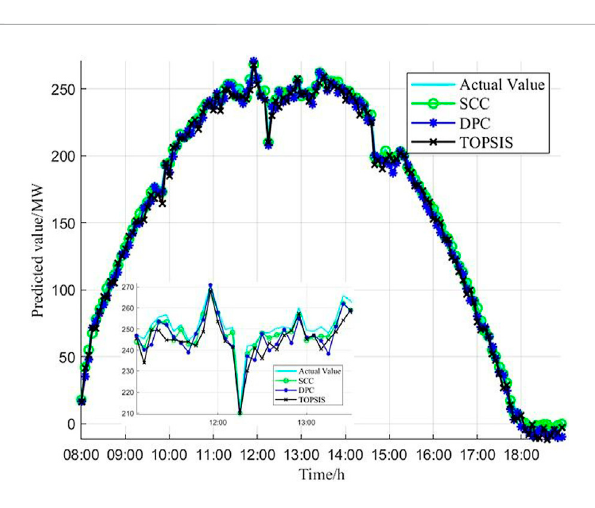
FIGURE 5 Simulation comparison of PV power prediction results by three coef fi cients.